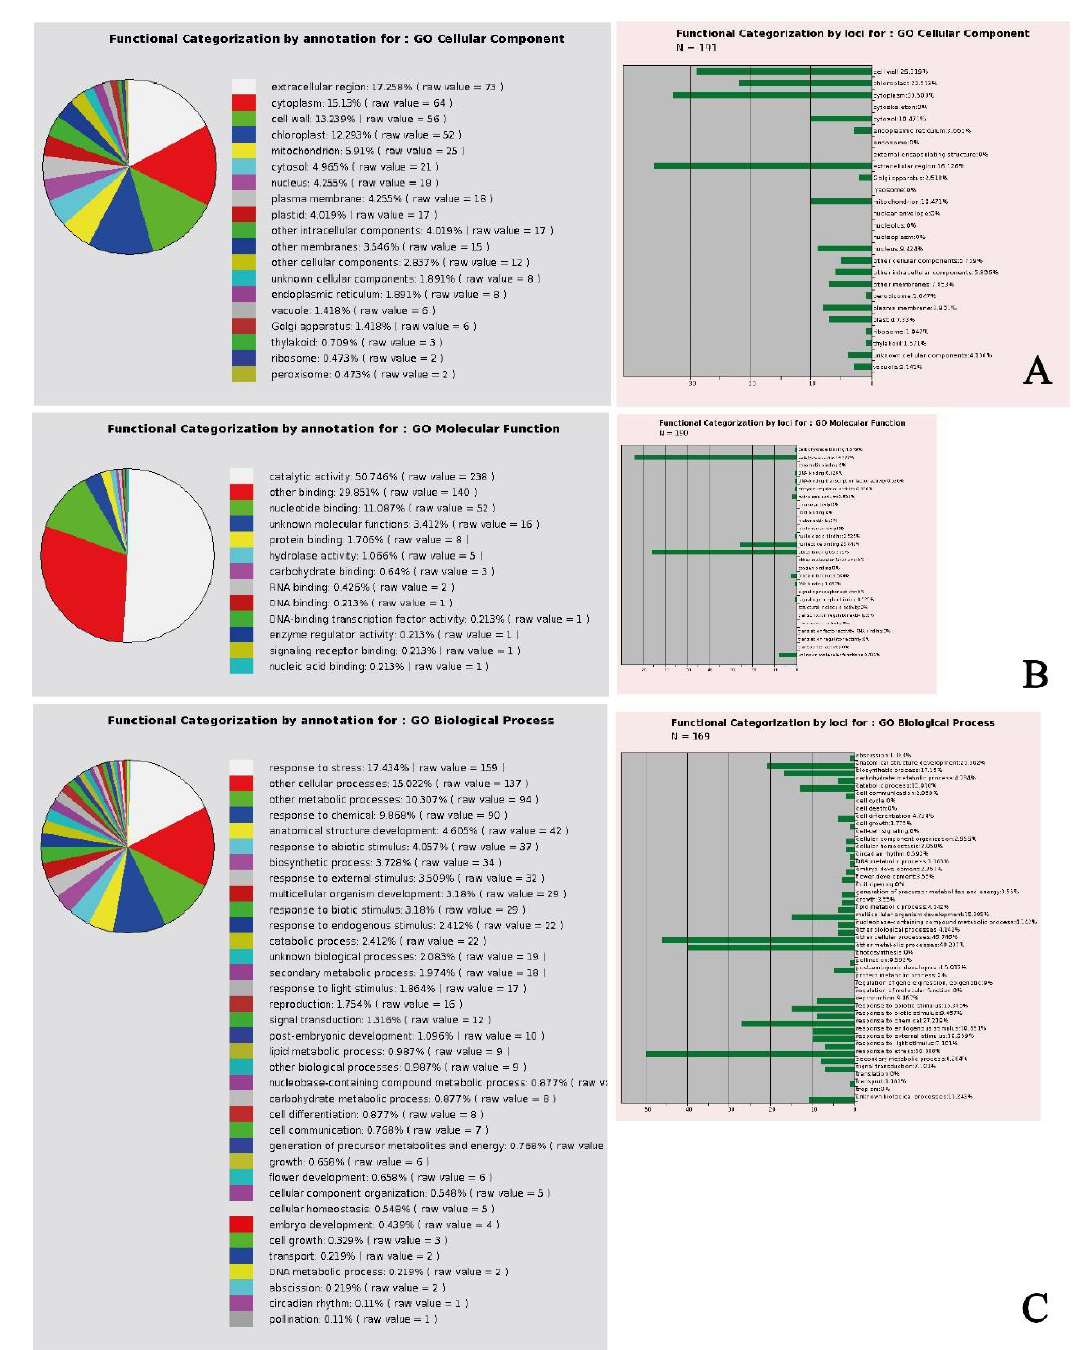
Figure 1. Gene ontology analysis of Arabidopsis thaliana genes selected for their involvement in oxidative stress. ( A ) Cellular component; ( B ) molecular function; ( C ) biological process. See text for further explanation.